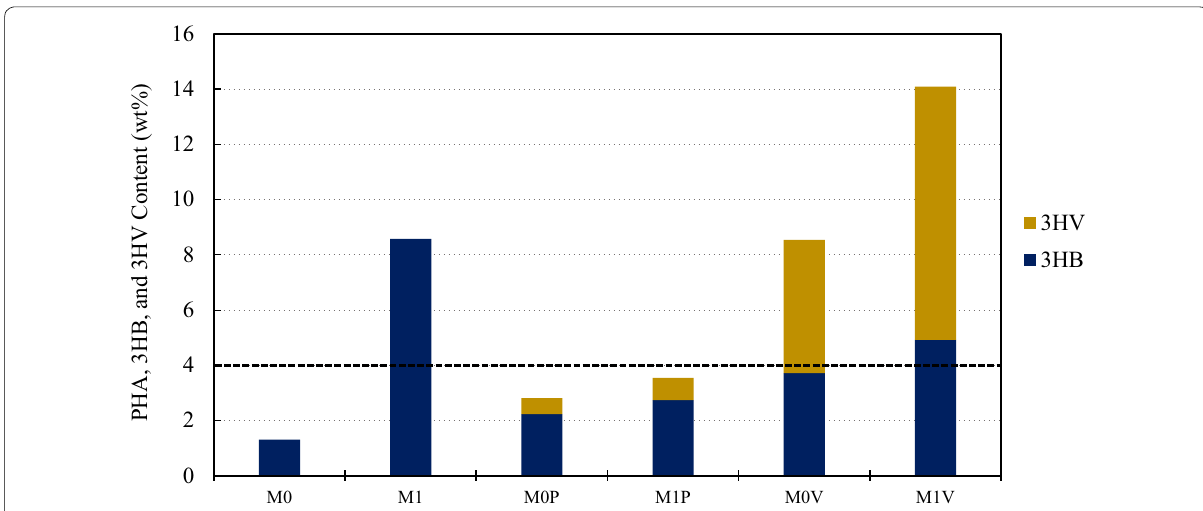
The content and composition of PHA was measured after 72 h of incubation in the presence and absence of methane with supplementation of odd-chain fatty acids